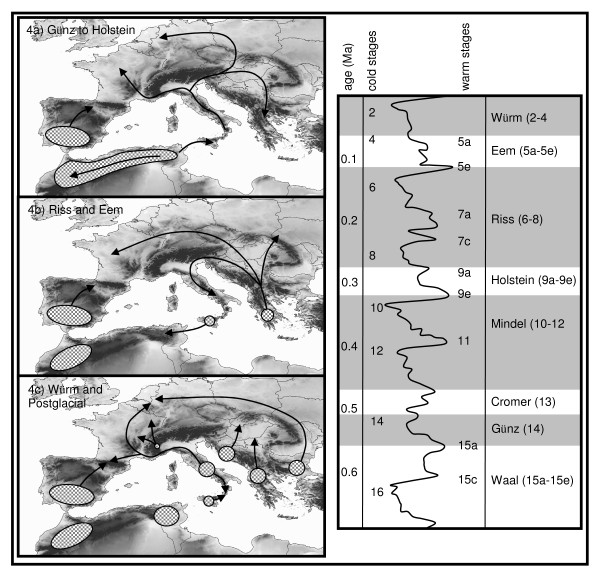
Biogeographic scenario of Melanargia galathea and M. lachesis. Range expansions and retractions of M. galathea and M. lachesis (on the Iberian Peninsula) during the past ice-ages (a-c) and fluctuations of marine isotope stages (d) (redrawn after Gibbard & van Kolfschoten [33]). Refugia are marked by grey areas, expansions/retractions by arrows. 4a) Günz and Mindel refugia in Iberia (M. lachesis) and the Maghreb (M. galathea); expansion from the eastern Maghreb to Sicily during the Mindel/Holstein transition; Holstein expansion over Europe, but retraction in the Maghreb to the west. 4b) Riss refugia in Iberia (M. lachesis) and the western Maghreb, Sicily and southern Balkans (M. galathea; Riss/Eem transition expansion from Sicily to the eastern Maghreb; Eem expansion of the southern Balkan group over major parts of Europe including peninsular Italy. 4c) Würm refugia in Iberia (M. lachesis) as well as western and eastern Maghreb, Sicily, peninsular Italy, southwestern Alps and Balkan area (M. galathea); postglacial expansion from Iberia (M. lachesis), peninsular Italy and the Balkan area (M. galathea).